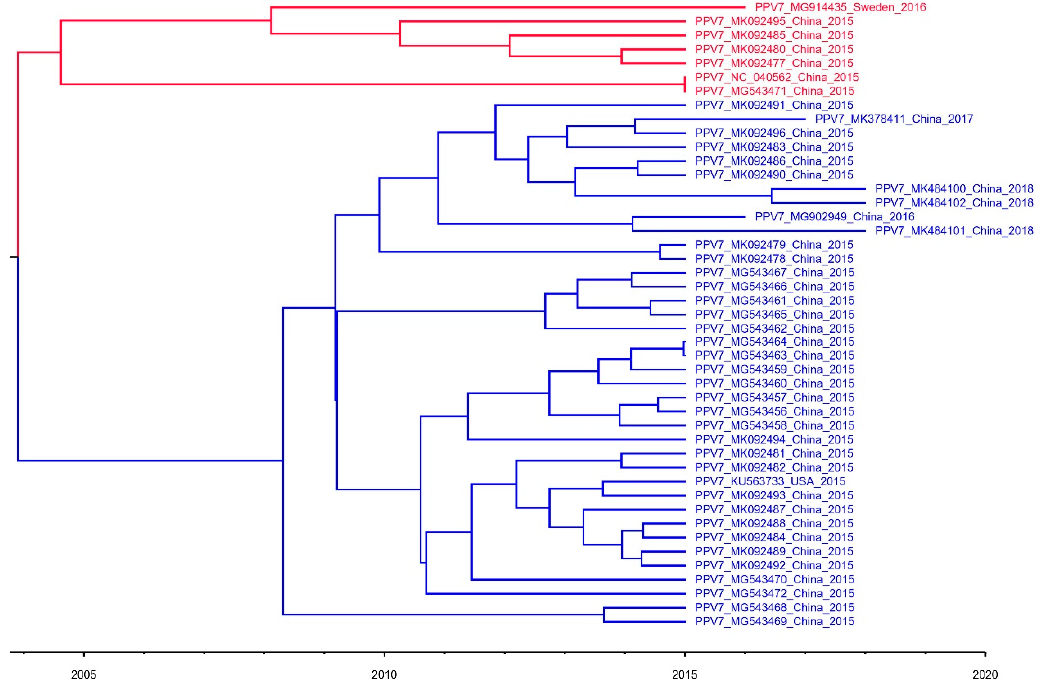
Figure 2. Maximum clade credibility (MCC) tree for the complete genome sequences of PPV7. The tree contained 2 major clades: Clade 1 (red) and Clade 2